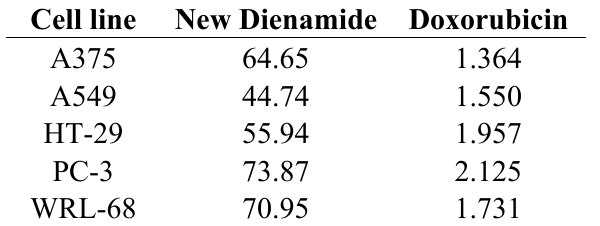
Table 2. Effect of compounds ( − )-kunstleramide ( 1 ) and doxorubicin (positive control) on